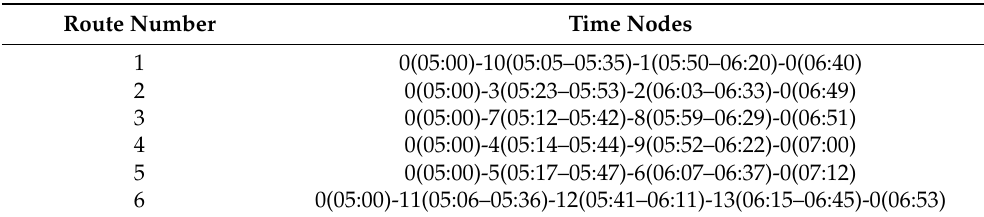
Table 12. Optimization of vehicle travel time nodes